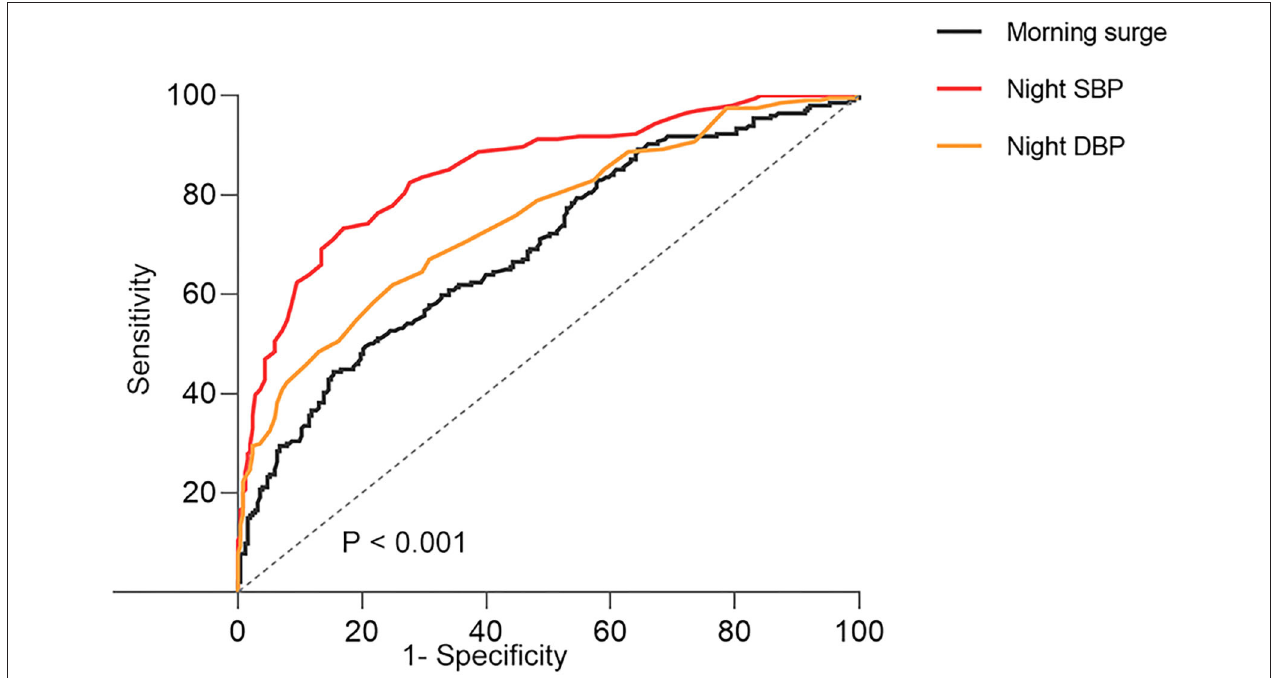
FIGURE 1 | The ROC curves of morning surge in blood pressure and night blood pressure about morning hypertension. SBP, systolic blood pressure; DBP, diastolic blood pressure; ROC, receiver-operating characteristic.